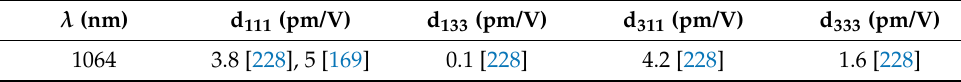
Table 29. Nonlinear coefficients of GUHP.